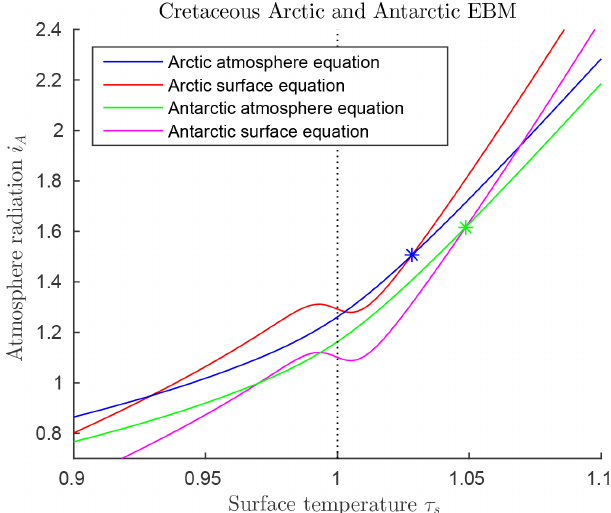
Figure 8. Solutions of the mid-Cretaceous EBM for both poles, using parameter values in Table 3. The blue and orange curves rep- resent the EBM for the Arctic while the green and magenta curves represent the Antarctic. The two Z-shaped curves represent the sur- face equilibrium equations for the Arctic (upper orange curve) and the Antarctic (lower magenta curve). The only differences in these two are that ocean heat transport F O is much greater in the Antarc- tic than the Arctic, and the atmospheric transport, F A , is smaller. Both poles support both warm and frozen equilibrium paleoclimate states. The warm equilibrium states at the two poles are marked by